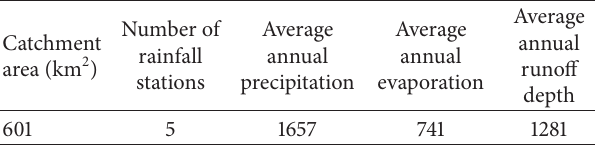
Table 2: Yandu River